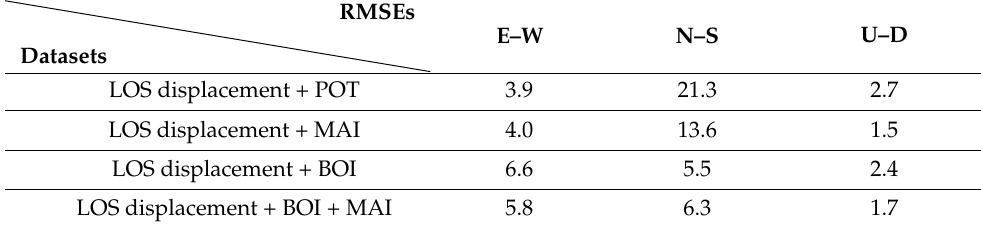
Table 3. Accuracies of InSAR-derived 3D displacements in comparison to GNSS data (unit: cm).